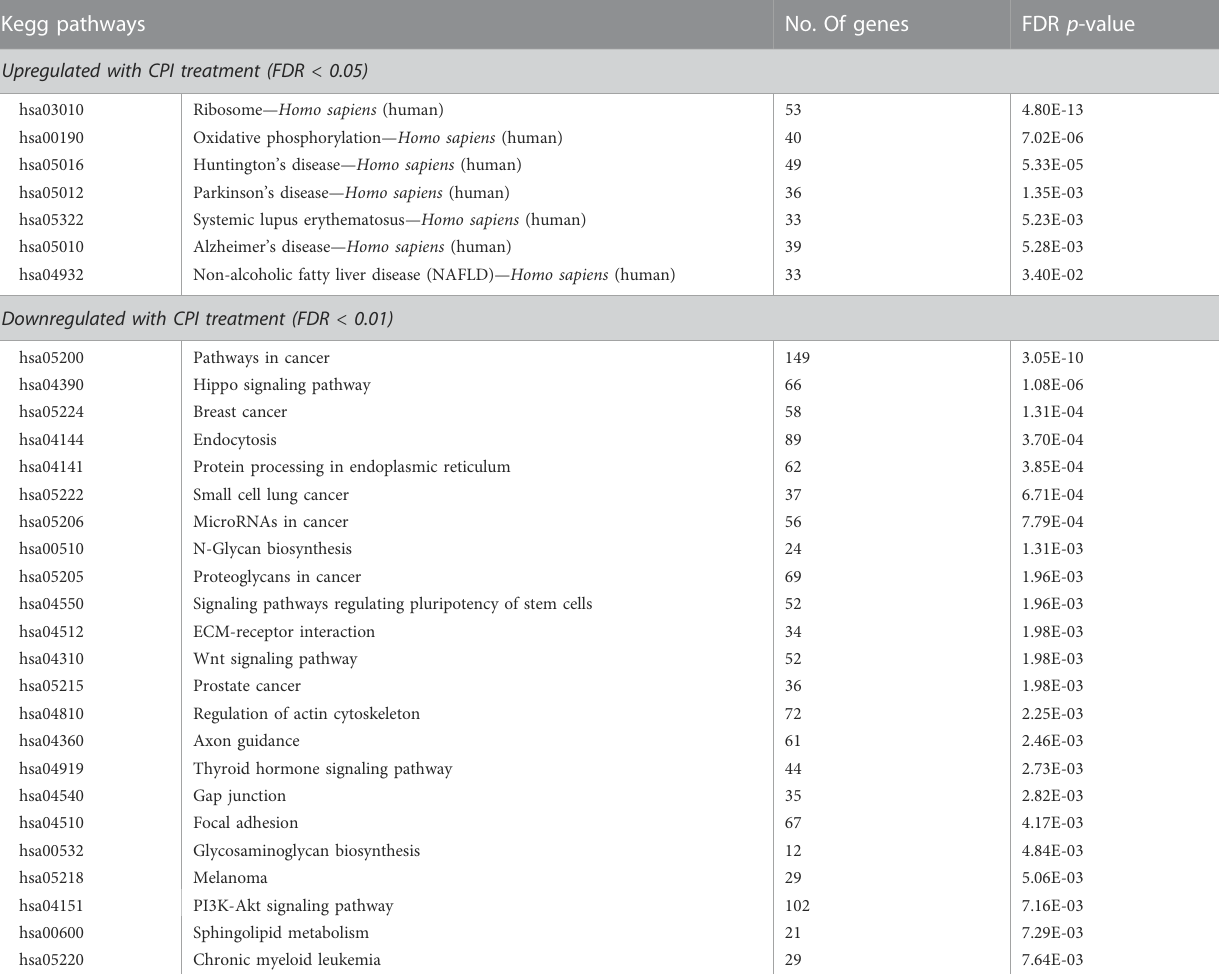
TABLE 2 Pathway analysis of differentially expressed genes (fold change log2 ≥ 1 and FDR - p -value ≤ 0.05) with CPI-455 treatment in LNCaP. Kegg pathways No. Of genes FDR p -value Upregulated with CPI treatment (FDR < 0.05)